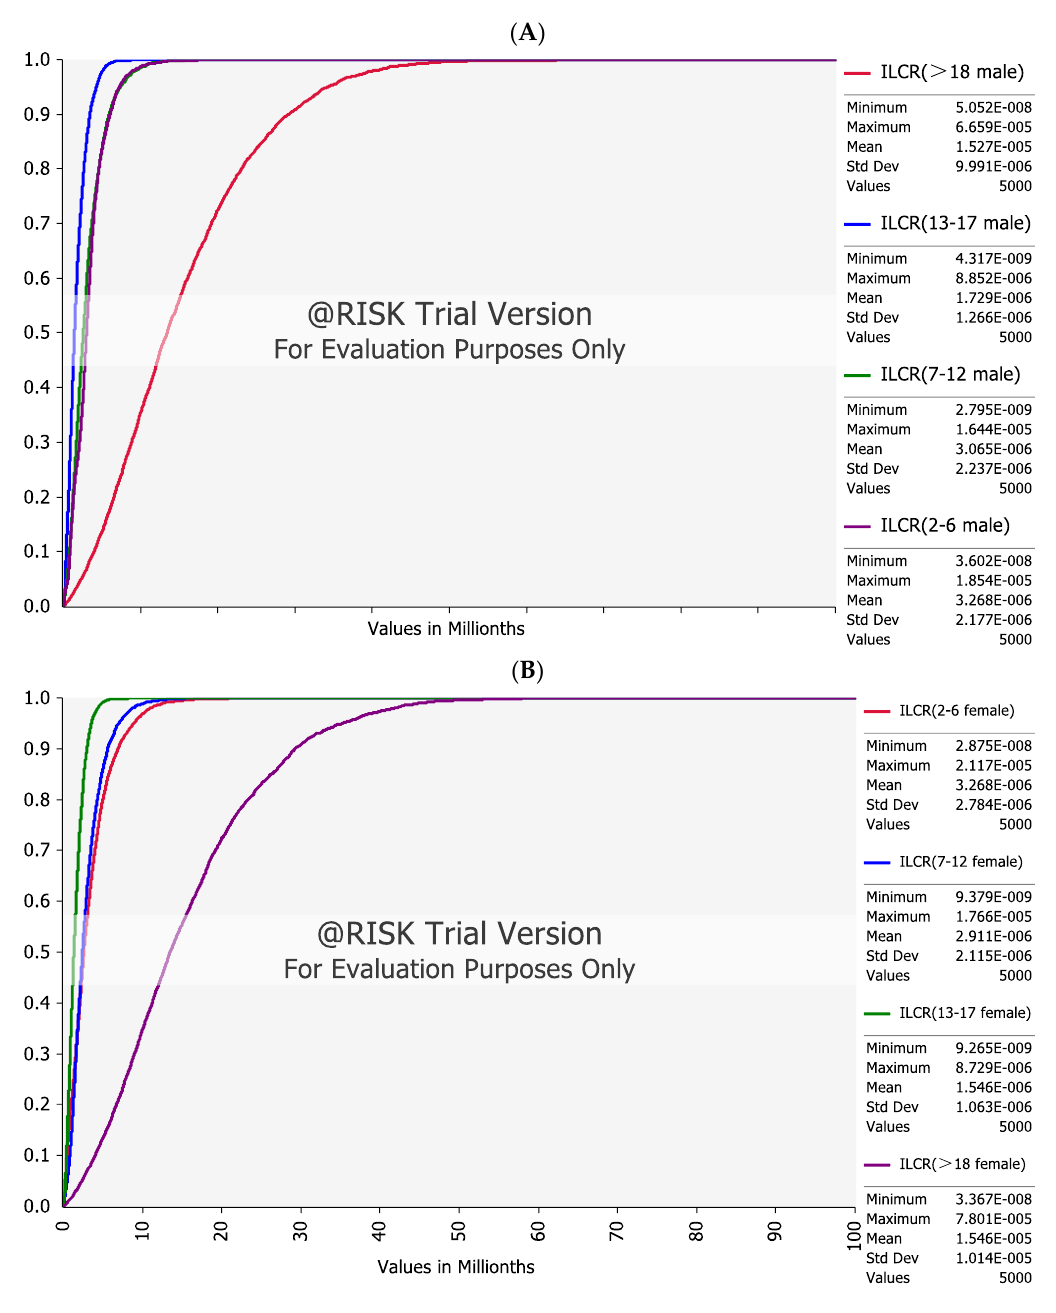
Figure 2. Cumulative probability of ILCR from vegetable oils in China. ( A ): male; ( B ): female. For males (A), the mean ILCR values were estimated to be 3.27 × 10 − 6 , 3.07 × 10 − 6 , 1.73 × 10 − 6 , and 1.53 × 10 − 5 for preschoolers, school-age youths, teenagers, and adults, respectively; for females (B), the mean ILCR values were estimated to be 3.27 × 10 − 6 , 2.91 × 10 − 6 , 1.55 × 10 − 6 , and 1.55 × 10 − 5 , respectively. The cumulative probabilities of the ILCRs of different age groups were less than the priority risk level (10 − 4 ). Furthermore, 2.5% to 36.5% of ILCRs were below the lower limit of the safe acceptable range (10 − 6 )